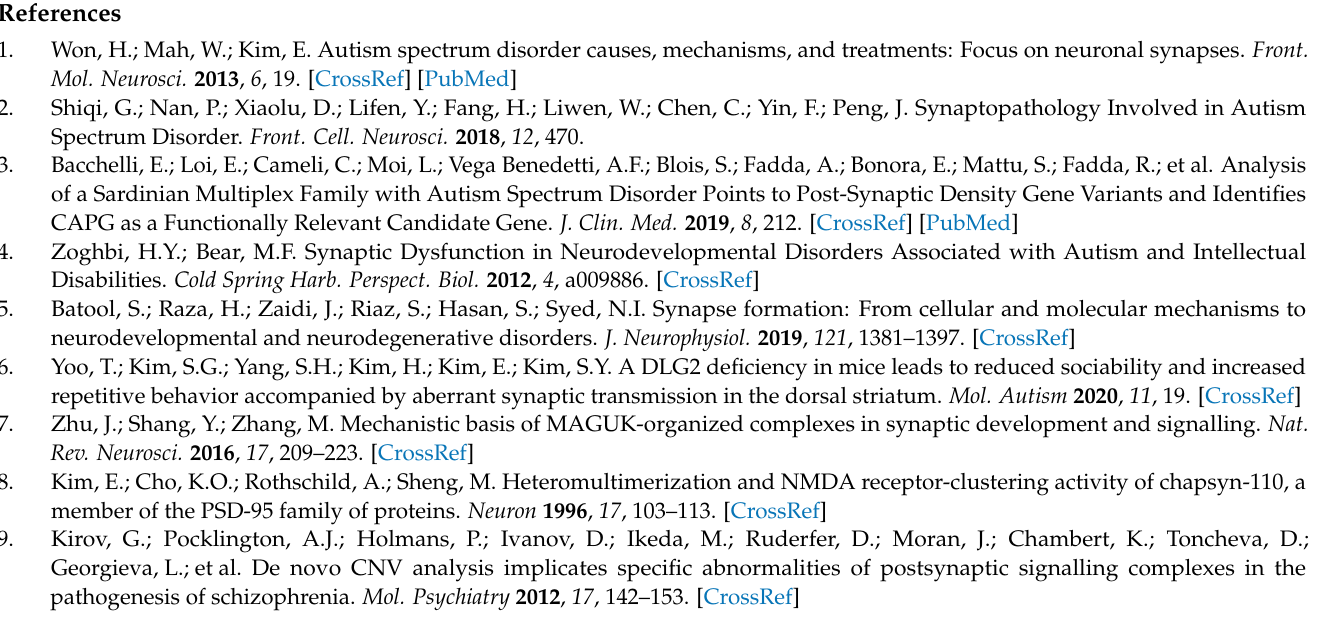
6. Table S3: Coding sequences involved in the CNVs of DLG2 gene. Table S4: DLG2 protein coding transcripts involved in patients’ imbalances. Figure S1: Expression of some DLG2 transcripts across tissues from GTEx